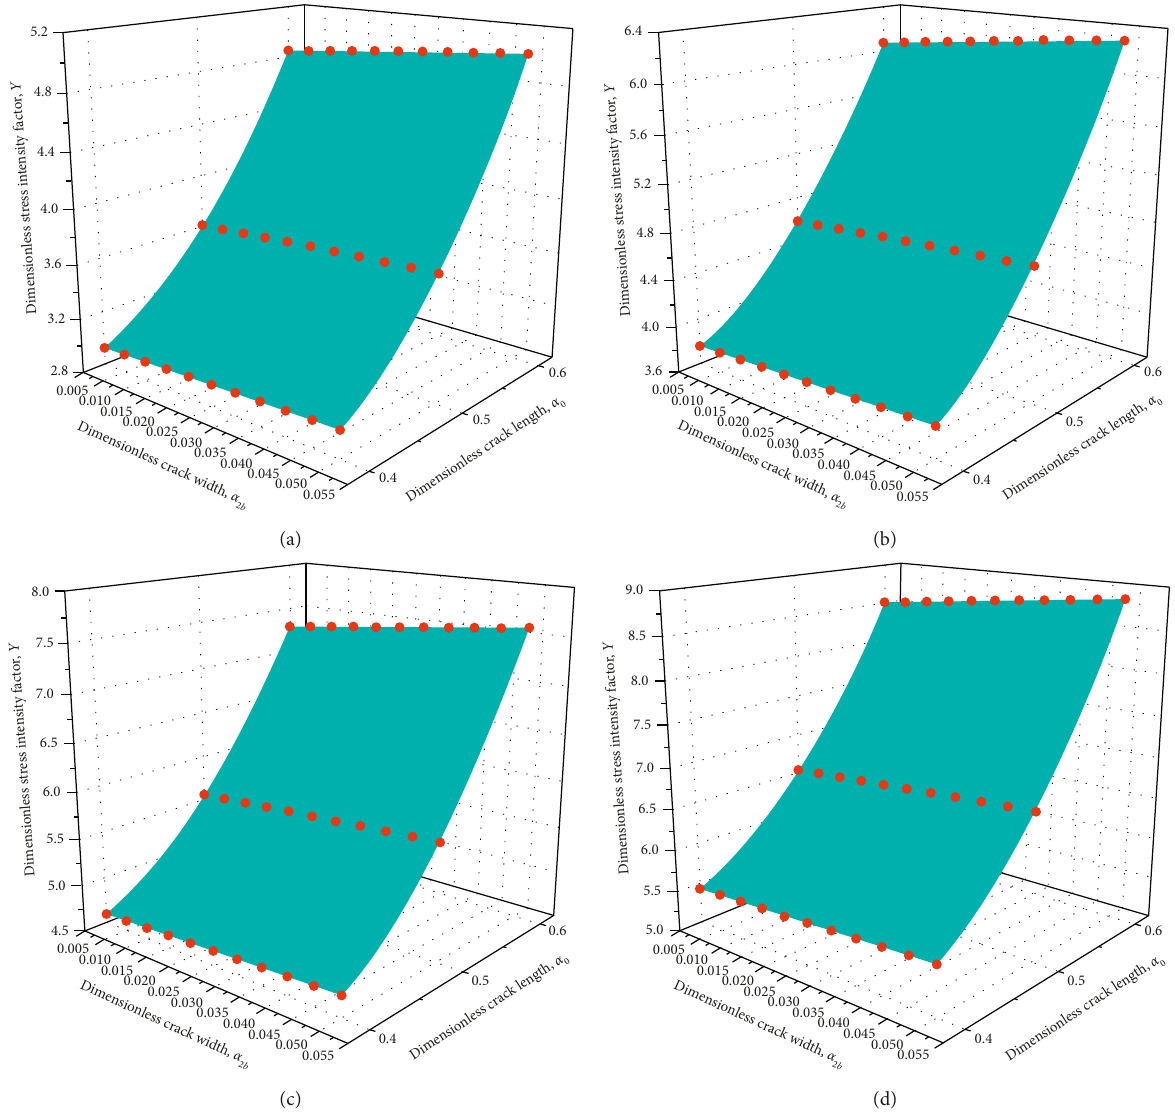
� 0.5, (b) α � 0.6, (c) α � 0.7, S S S